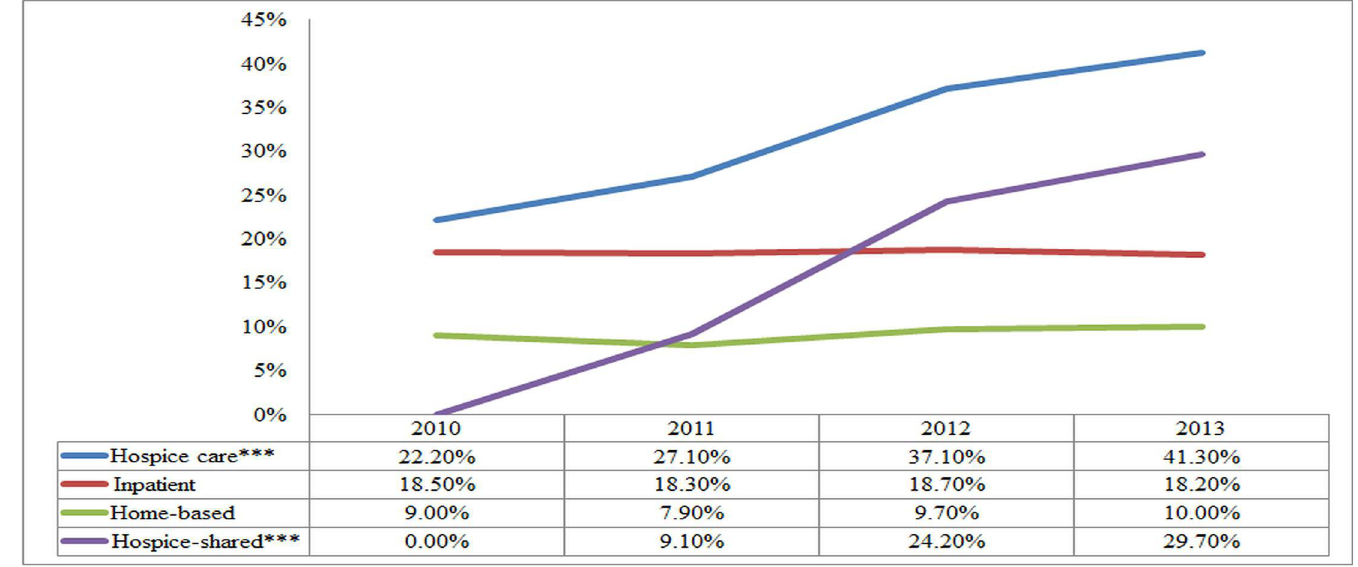
Fig 2. Flow chart of the sampling and matching process. CCI = Charlson Comorbidity